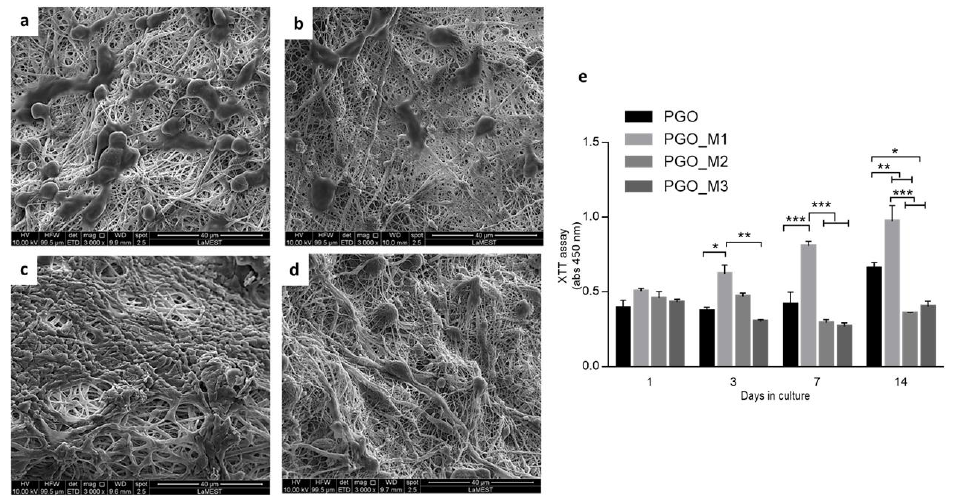
Figure 12. SEM images of L929 cells onto PGO ( a ), PGO-M1 ( b ), PGO-M2 ( c ), and PGO-M3 ( d ) nanofibers. Scale bar: 40 μm. ( e ) XTT assay for biocompatibility of nanofibers at 1, 3, 7, and 14 days. Results are presented as the average ± standard error of the mean. * Represents statistical significance (* p < 0.05, ** p < 0.01, *** p < 0.001).